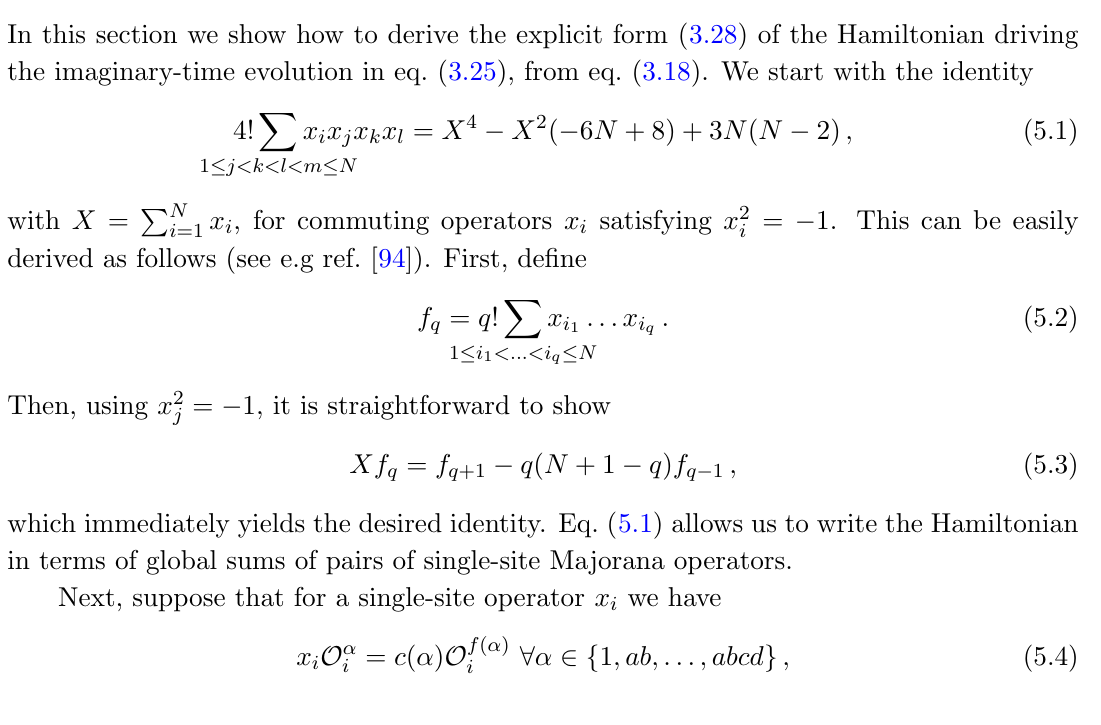
Figure 10 . Time evolution of the R(cid:19)enyi-2 entropies S (2) in (cid:12)gure 2, for N = 200 and di(cid:11)erent values of (cid:22) ‘ . Solid lines in sub(cid:12)gures ( a ) and ( b ) correspond, respectively, to times t = 0 ; 0 : 2 ; 0 : 4 ; 1 (from top to bottom) and t = 2 ; 4 ; 6 ; 15 (from bottom to top). The black dashed line in Sub(cid:12)gure ( b ) is obtained by Haar average as computed in ref.